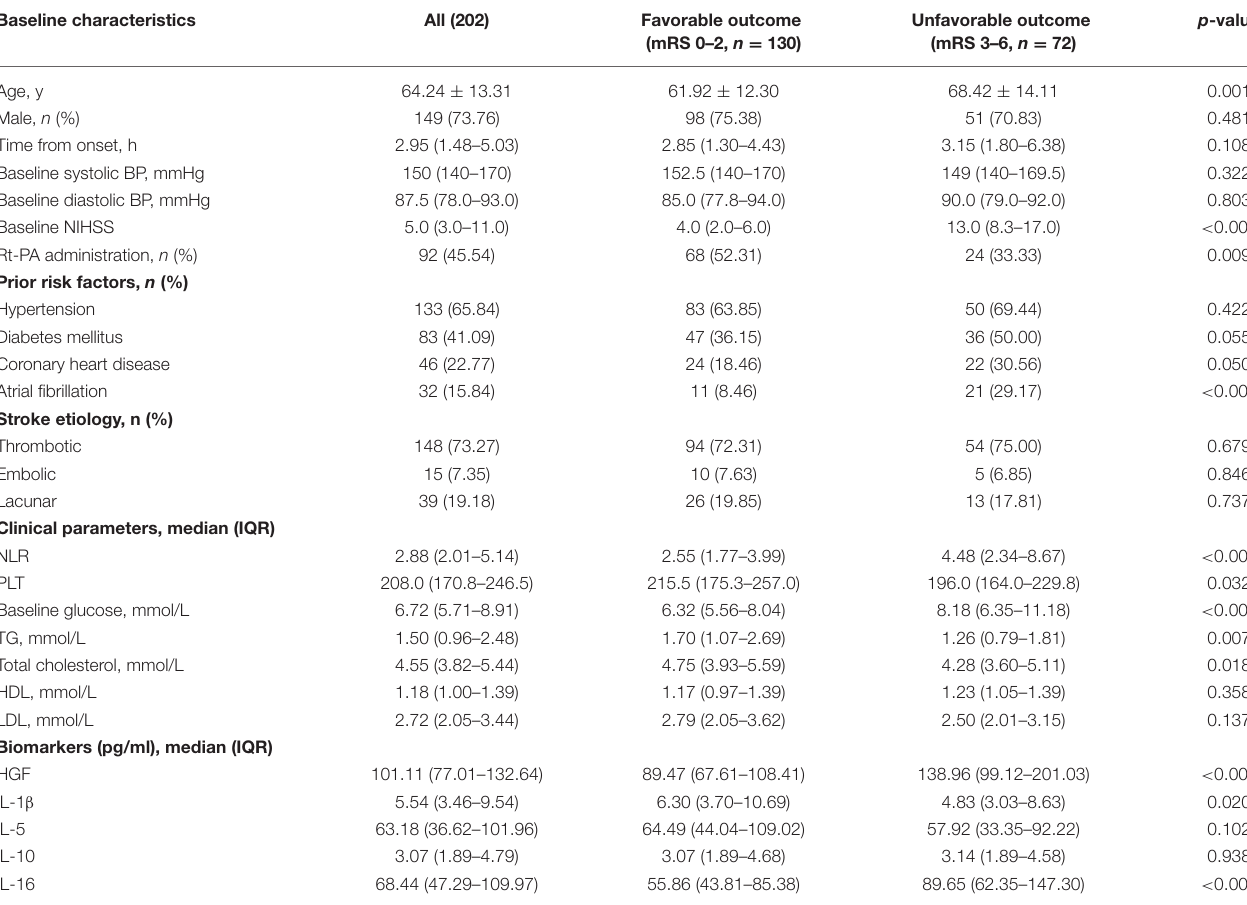
TABLE 1 | Clinical characteristics and inflammatory cytokines of AIS patients with favorable and unfavorable outcomes. Baseline